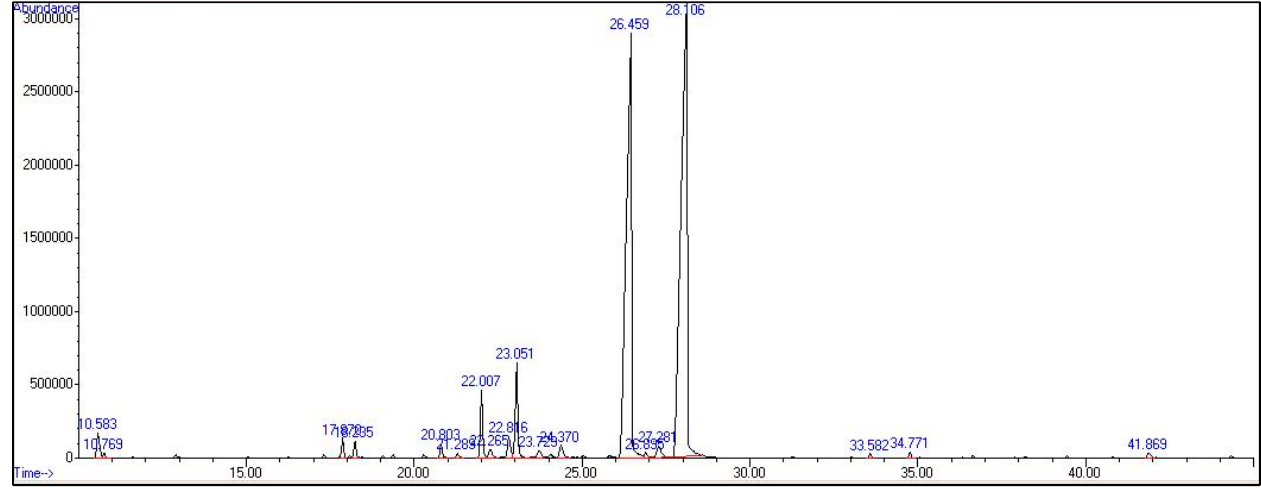
Figure 1. Chromatogram of B. citriodora EO (BCEO) compounds derived from GC–MS.